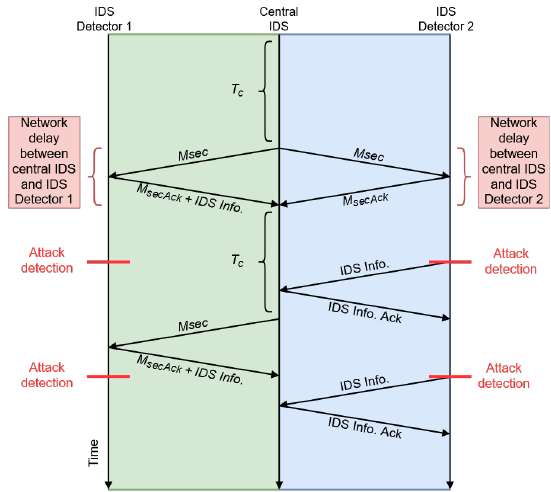
Figure 4. Diagram of central IDS and IDS detector communication